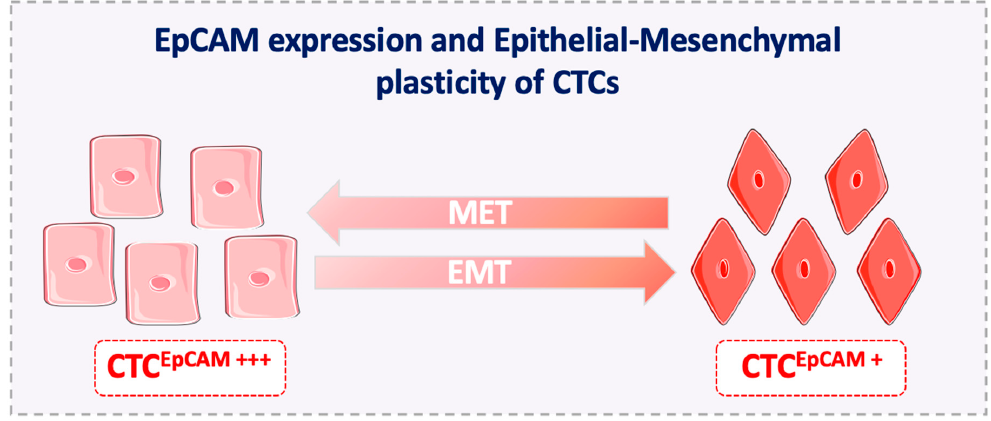
Figure 3. EpCAM expression and epithelial-mesenchymal plasticity of CTCs. CTCs that undergo EMT obtain an intermediate phenotype and often continue to express EpCAM. Indeed, the downregulation of EpCAM expression, if initiated, is rarely complete during the EMT in CTCs. EMT, epithelial-to- mesenchymal transition; MET, epithelial-to-mesenchymal